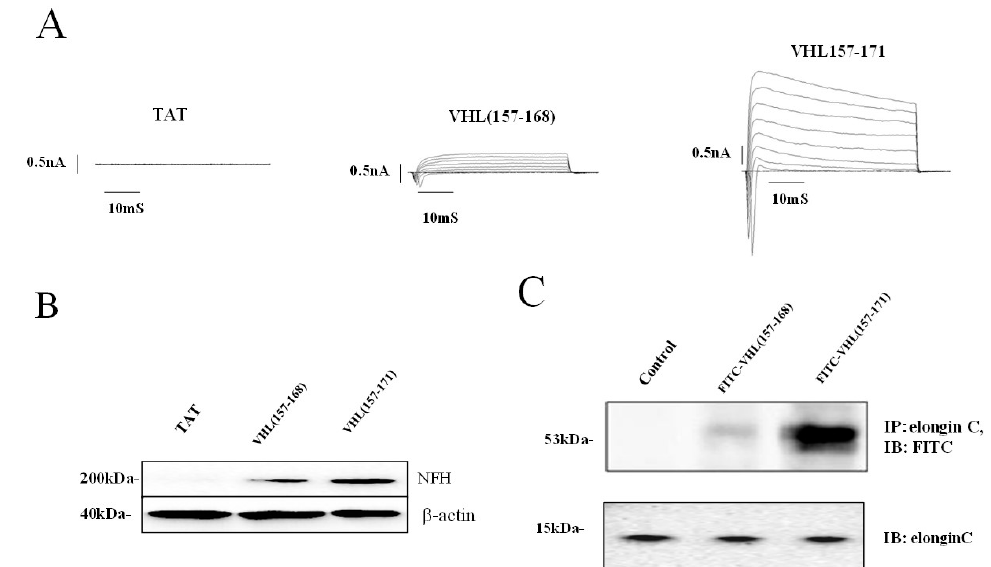
Figure 3. ( A ) Electrophysiological properties of peptide-treated cells. Voltage-gated inward and outward currents were recorded in the whole-cell patch-clamp configuration. ( Left ) TAT(YARAAARQARA)-treated cells. No currents are seen. ( Center ) VHL(157–168)-treated cells. Small outward K + currents and fast inward Na + currents are seen. ( Right ) VHL(157–171)-treated cells. Shown in the graph are large outward K + currents and fast inward Na+ currents elicited by depolarizing voltage steps, which is a characteristic feature of a mature neuron; ( B ) Western blotting analysis using anti-NFH antibody for treated-treated cells. A distinct band for NFH was recognized for VHL(157–171)-treated cells, whereas a less distinct band for NFH for VHL(157–168)-treated cells ( p < 0.01) and a faint band was found for TAT(YARAAARQARA)-treated cells ( p < 0.001); ( C ) Immunoprecipitation (IP) with anti-elongin C using fluorescein-4-isothiocyanate (FITC)-VHL(157–171)-treated cells or FITC-VHL(157–168)-treated cells. A distinct band for FITC was recognized for FTIC-VHL(157–171)-treated cells, whereas a faint band for FITC was found for FITC-VHL(157–168)-treated cells and no band was found for non-treated cells.